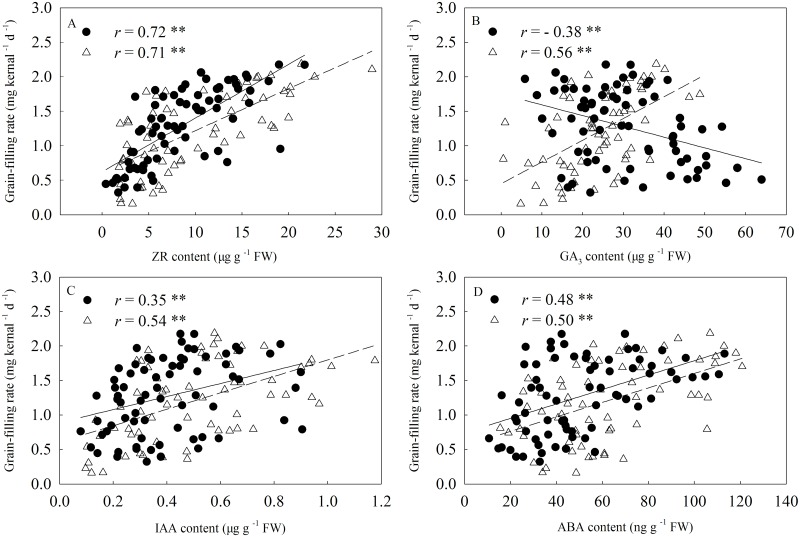
Relationship between grain-filling rate and the hormone concentrations in kernels.Closed circles and open triangles represent hormone concentrations at 3 to 15 days after anthesis (DAA) and at 18 to 28 DAA, respectively. The solid and short dotted line represent the regression line between grain-filling rate and hormone concentrations at 3 to 15 DAA (n = 72) and at 18 to 28 DAA (n = 64), respectively. Correlation coefficients (r) are calculated and asterisks (**) represent significance at the 0.01 probability level.